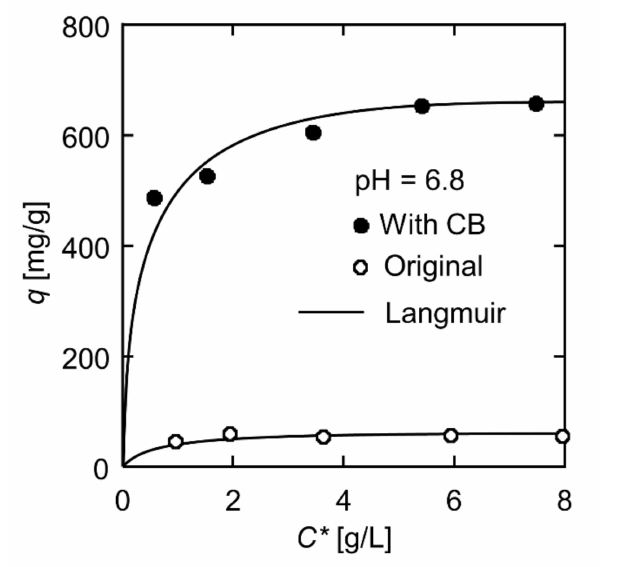
Figure 3. Effect of the BHb initial concentration on adsorption capacities of the original and CB- modified PVA nanofiber